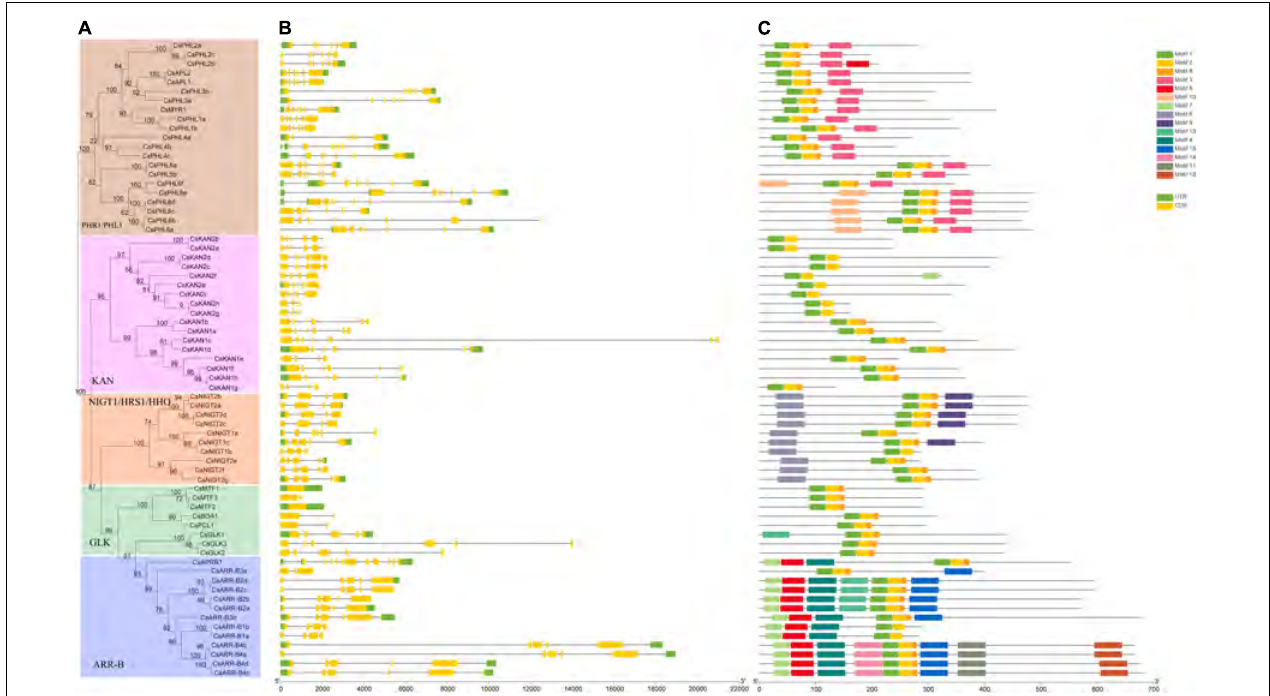
FIGURE 3 | Phylogenetic relationships, gene structure and conserved protein motifs of CsGARP TF genes. (A) The phylogenetic tree was constructed using the ML method; (B) gene structure of CsGARP TF genes; (C) motif composition of CsGARP proteins. The motifs are colored with different